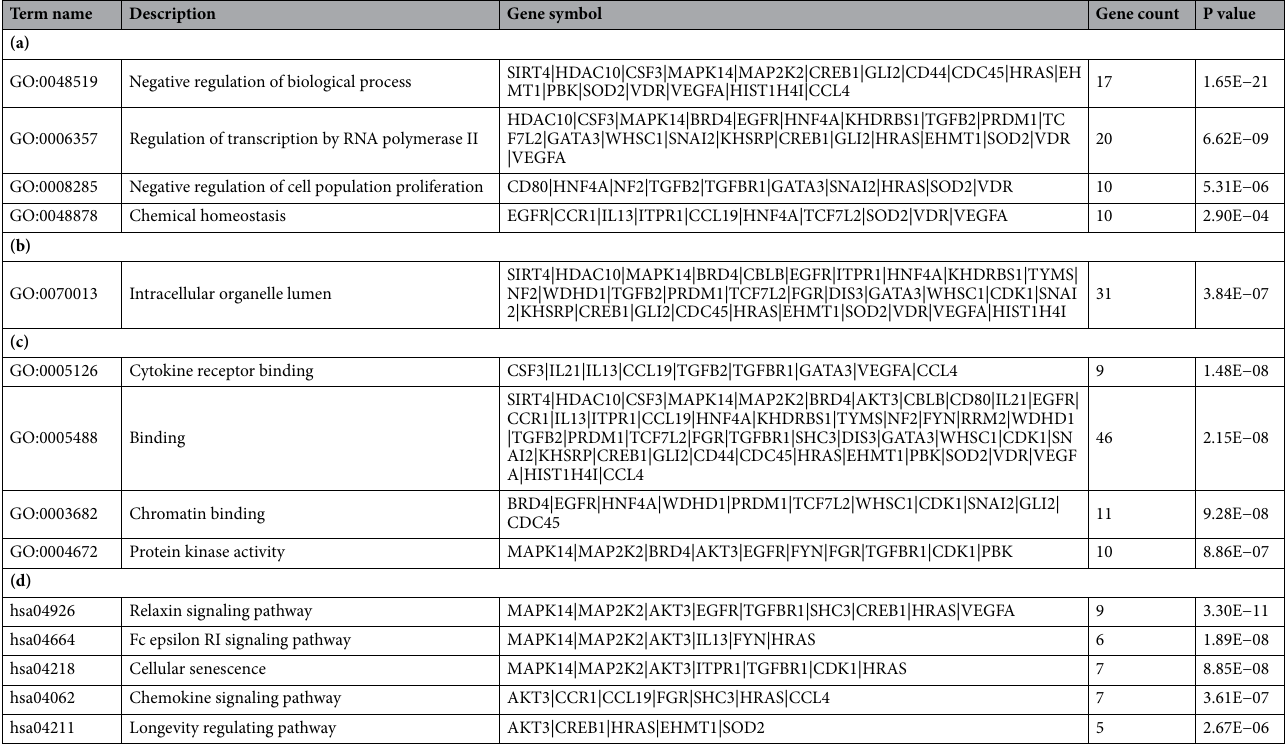
Table 3. Gene ontology and KEGG analysis of differentially expressed genes associated with SOD2 in recurrent spontaneous abortion. (a) Biological process (b) cellular component (c) molecular function (d) KEGG